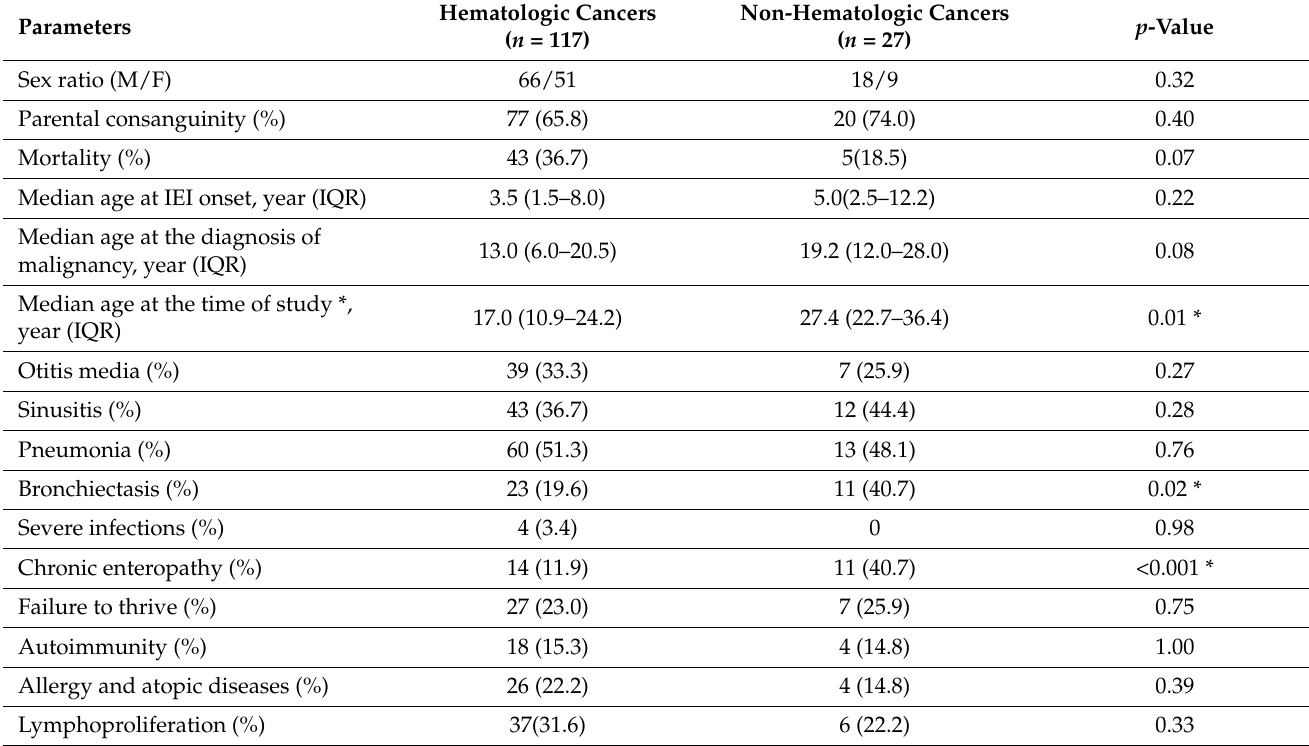
Table 1. Comparison of clinical and immunologic data of IEI patients with non-hematologic and hematologic